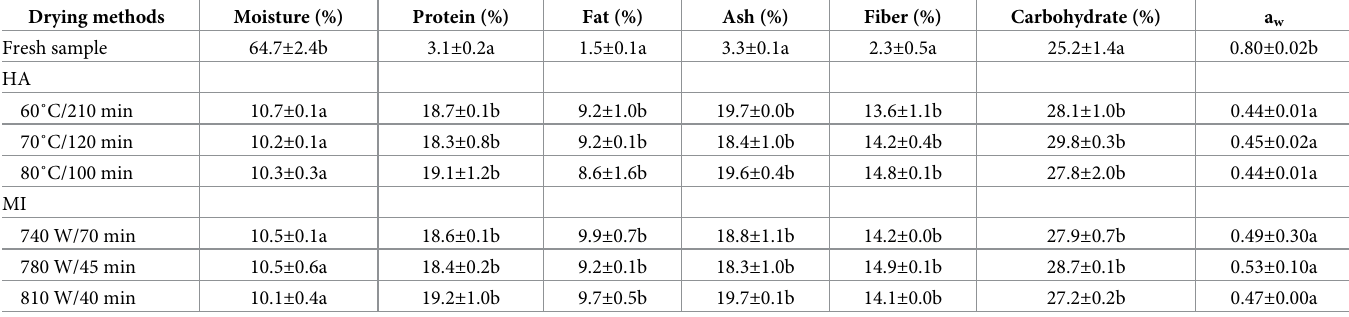
Table 1. Proximate composition and water activity (a w ) of Tai-Pla curry paste (fresh sample) and Tai-Pla curry powder (TCP) dried using hot air (HA) and hybrid microwave-infrared drying (MI) under different drying conditions. Drying